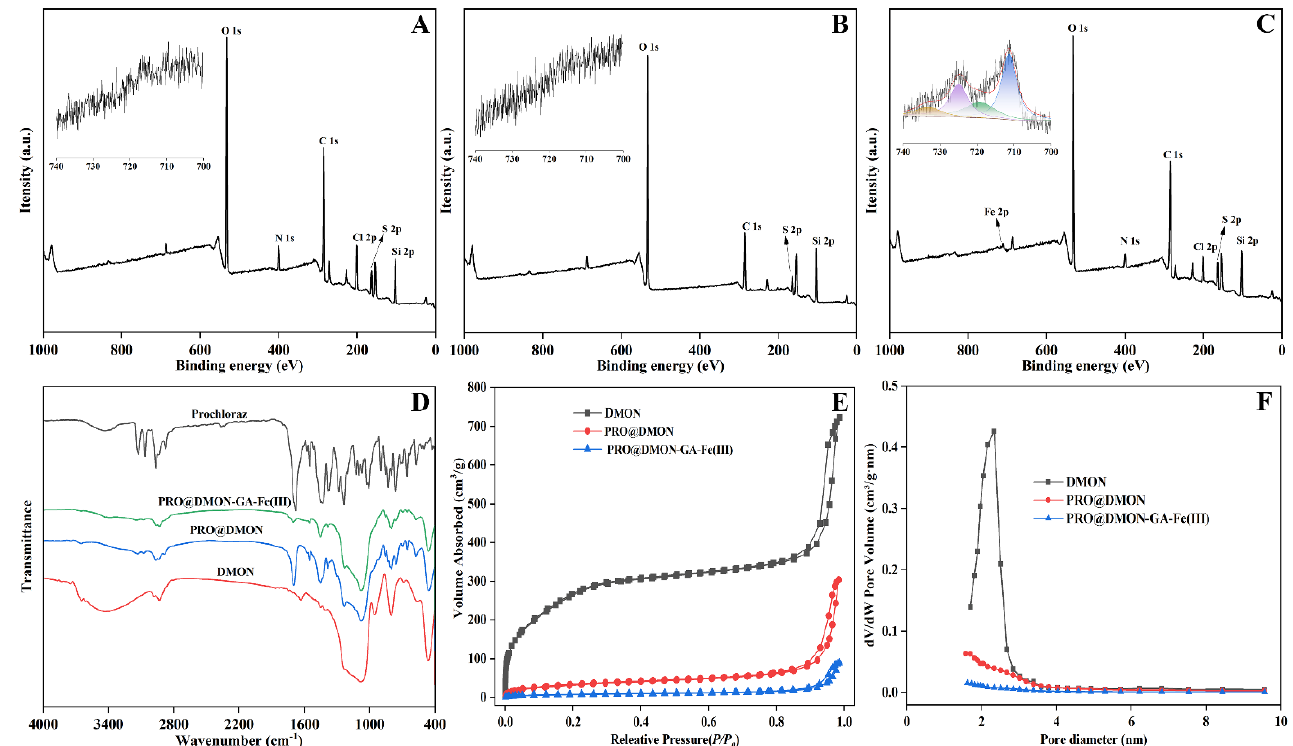
Figure 4. XPS spectra of DMON nanoparticles ( A ), PRO@DMON nanoparticles ( B ), and PRO@DMON–GA–Fe(III) nanoparticles ( C ). FTIR spectra of prochloraz, DMON nanoparti-